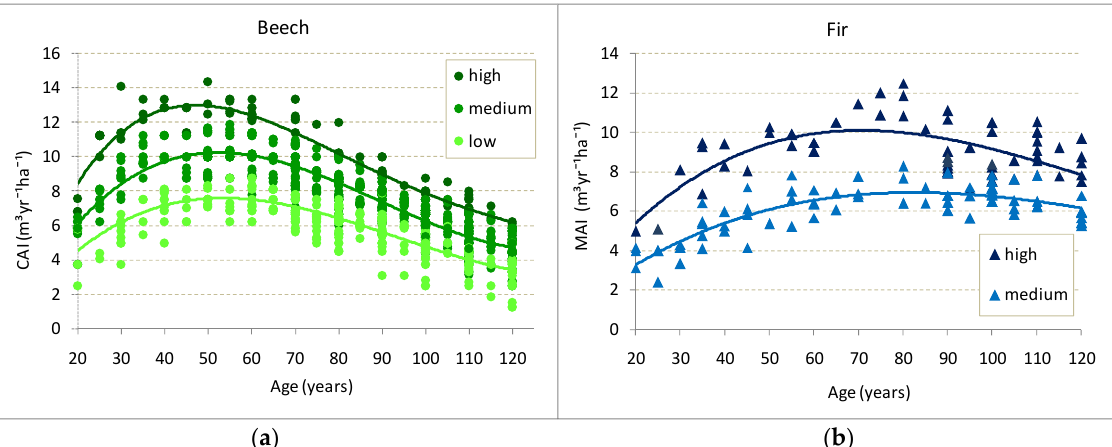
Figure 7. Current annual volume increment ( CAI ) for beech ( a ) and mean annual volume increment ( MAI ) for fir ( b ).